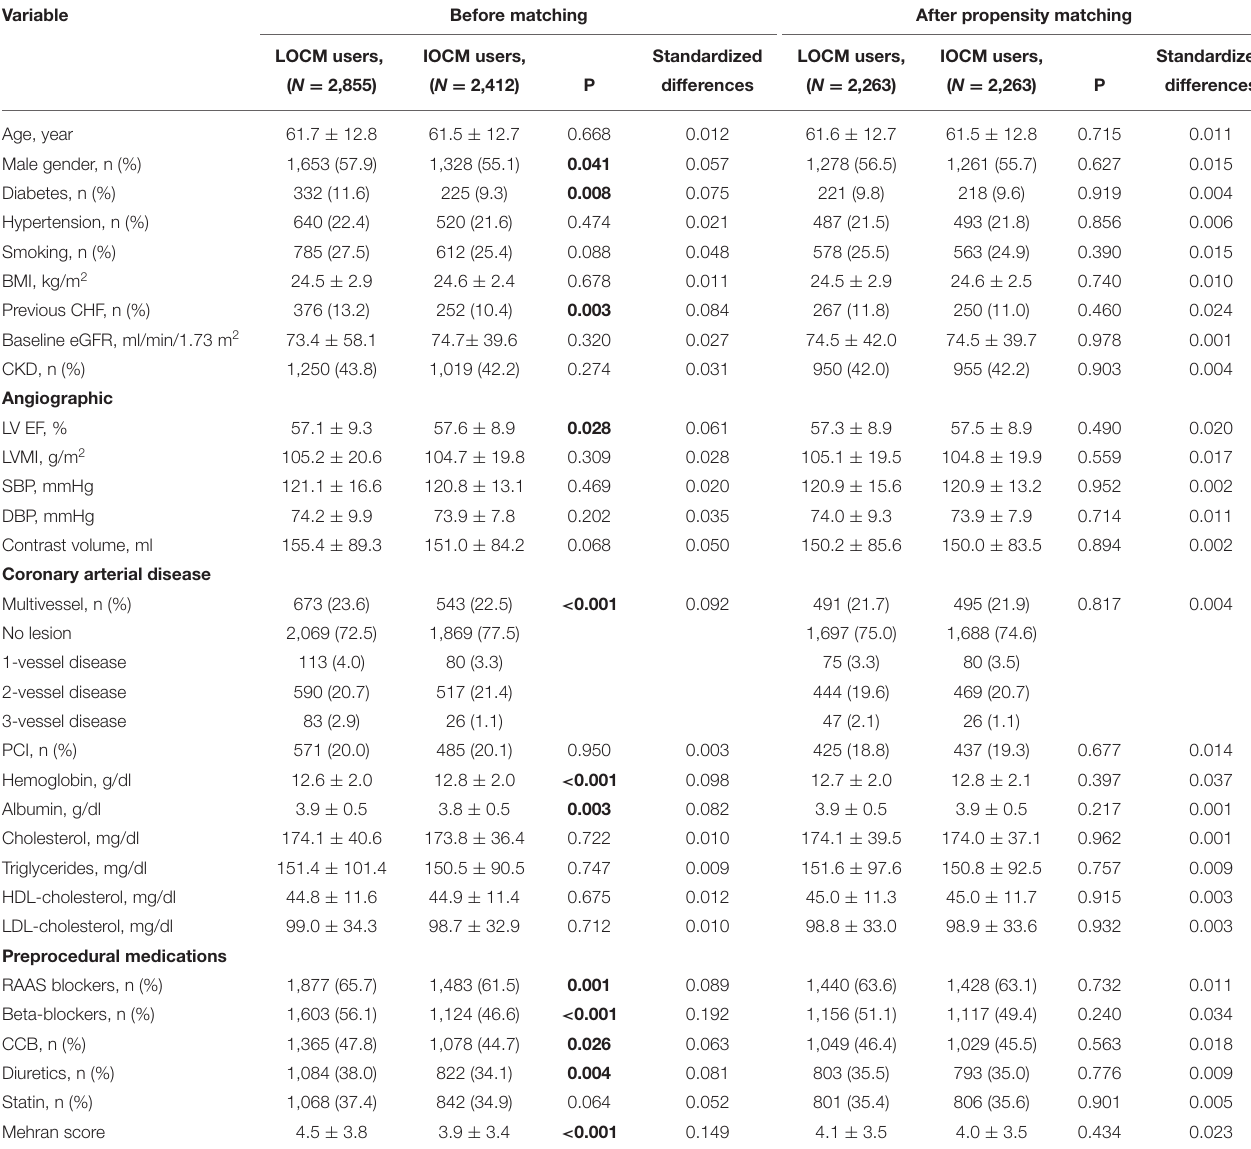
TABLE 1 | Baseline characteristics of the study participants. Variable Before matching After propensity matching LOCM users, IOCM users, Standardized LOCM users, IOCM